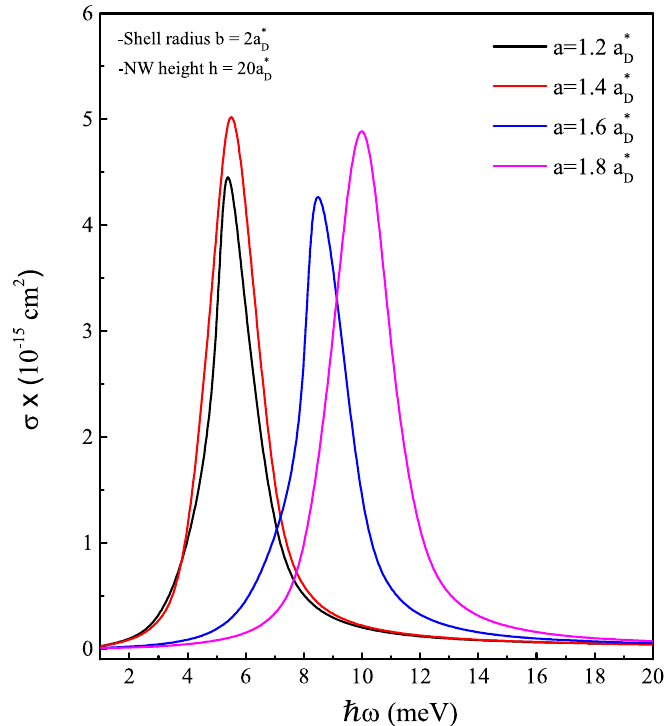
Figure 8. On-center donor impurity-related photoionization cross-section coefficient in cylindrical Al x Ga 1 − x As/GaAs-based core/shell NW as a function of the incident photon energy at zero magnetic